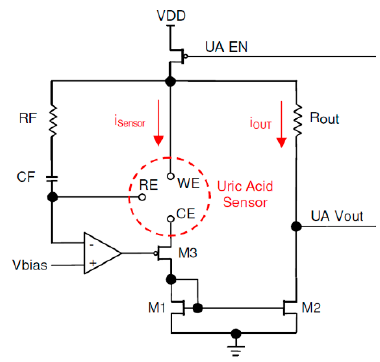
Figure 6. Amperometric readout circuit.